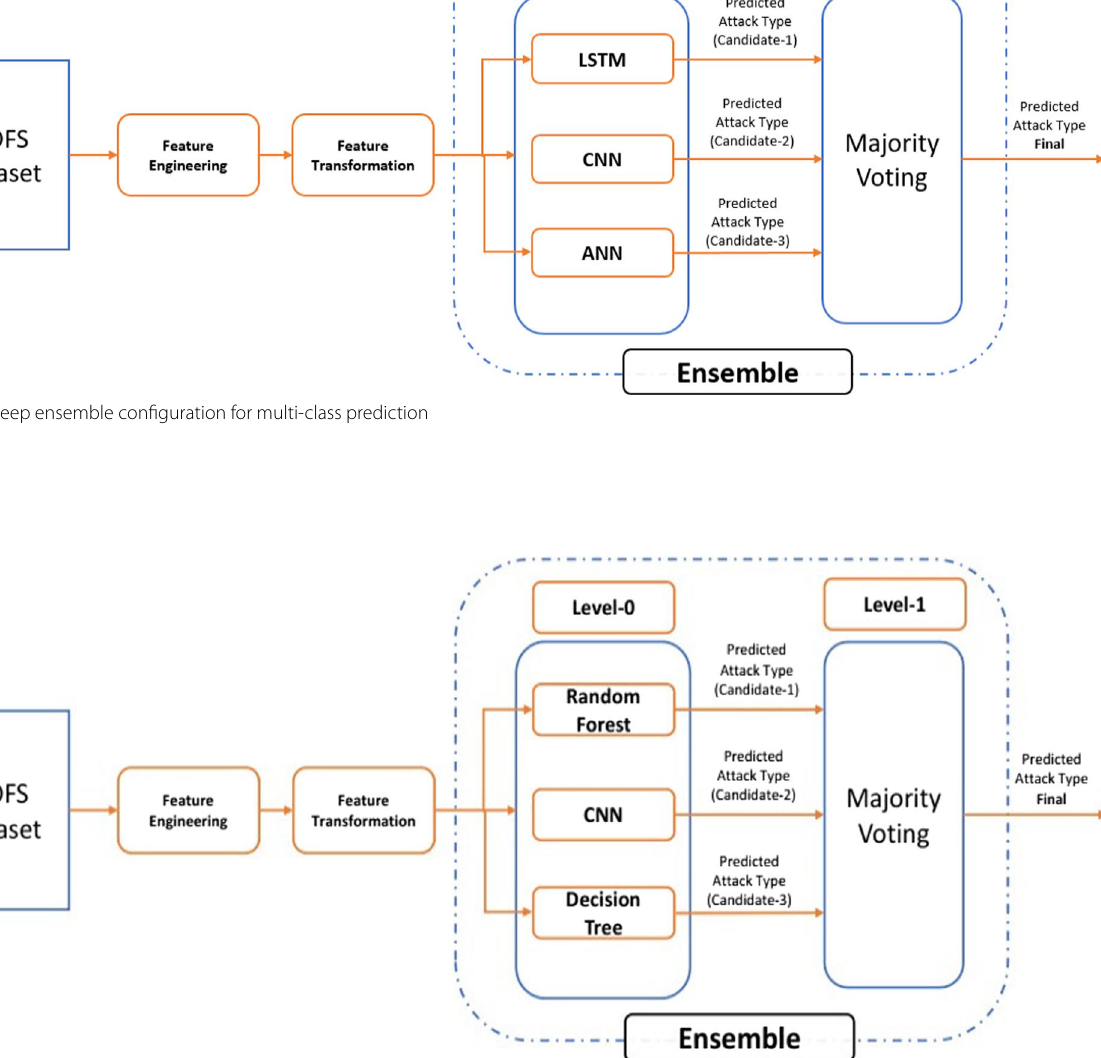
Fig. 5 Hybrid ensemble configuration for multi-class